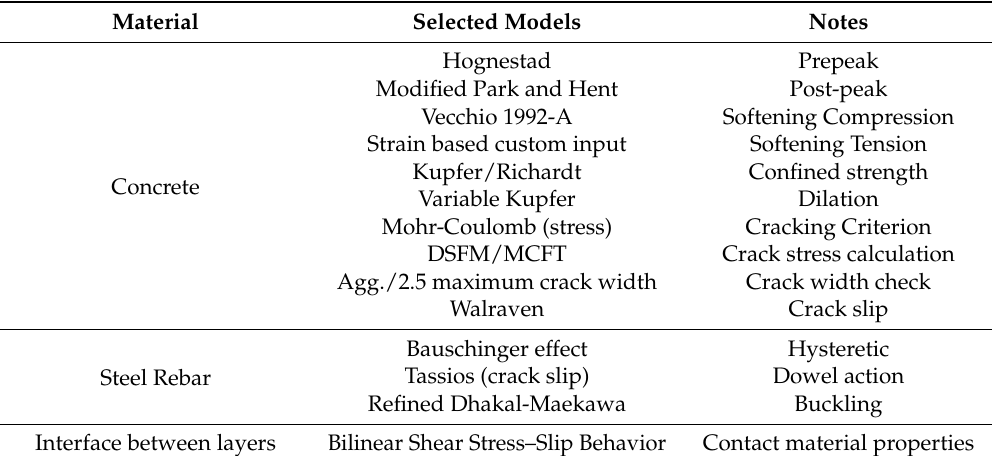
Table 4. Selected material models for estimating shear